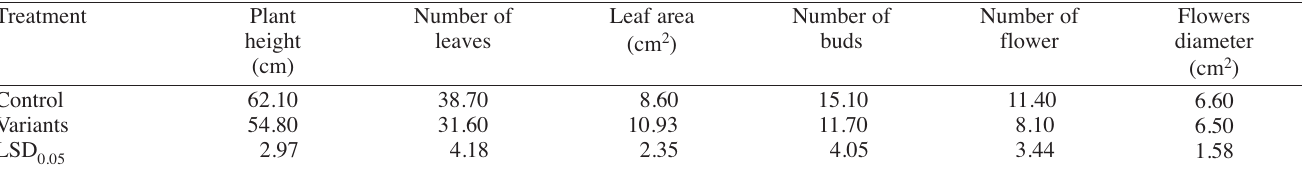
Table 2 - Analysis of variance of the morphological characters of control and variants of chrysanthemum Treatment